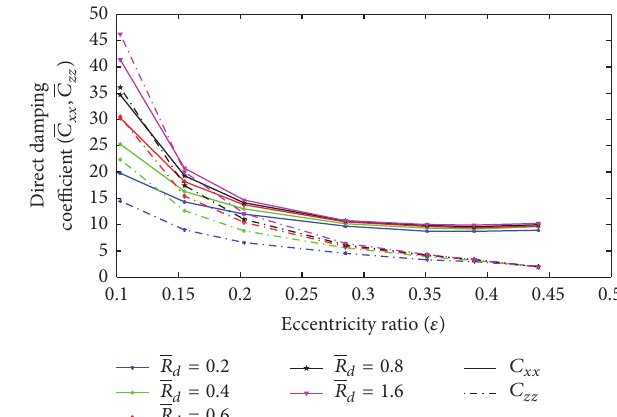
Figure 8: Effect of relief track depth ratio on direct stiffness coefficient.